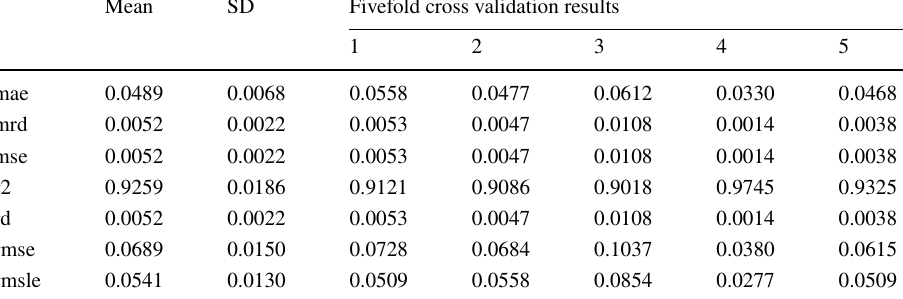
Table 3 Accuracy of the Deep Learning model for the wetting phase with cross validation for the five folds